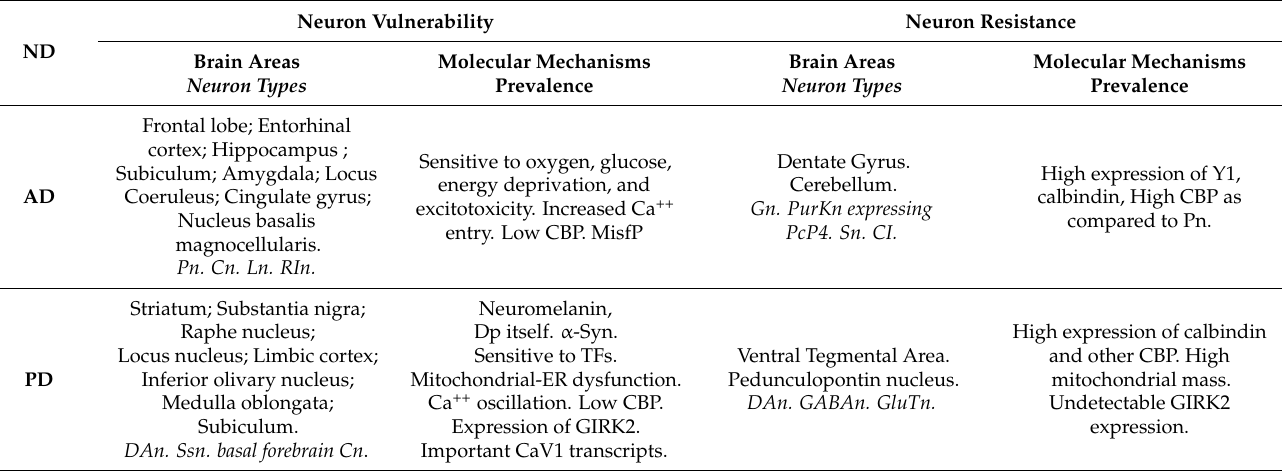
Table 2. Neuron vulnerability and resistance in major ND. Neurodegenerative disorders are char- acterized by proteostasis impairment and disruption of Ca ++ homeostasis and signaling. Despite intrinsically different etiologies, dysregulated Ca ++ emerged as a common underlying molecular mechanism of altered dendritic structure and neuronal loss in Alzheimer’s, Parkinson’s, Huntington’s diseases, amyotrophic lateral sclerosis, and Creutzfeld-Jakob neurodegenerative disorders suggesting that variations in Ca ++ buffering protein distribution and (Ca ++ ) ic dyshomeostasis underlies, at least partially, the differential